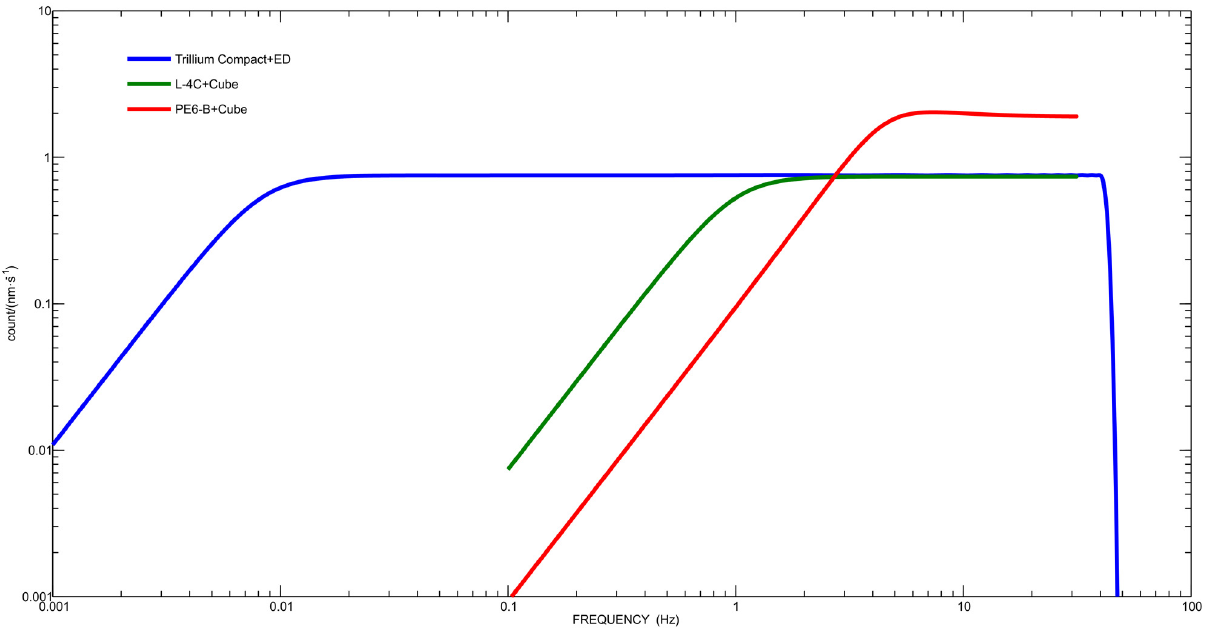
Figure 4. Response curve for the Trillium Compact (+EarthData), the Mark L-4C (+Cube) and the PE6/B (+Cube) seismometers. Curves have been calculated using the information described in the